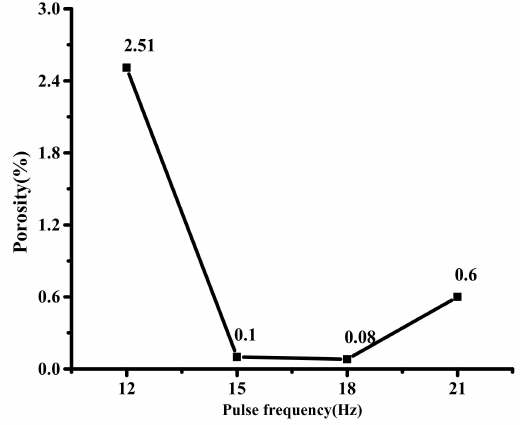
Figure 12. The pores distribution under di ff erent pulse frequencies.